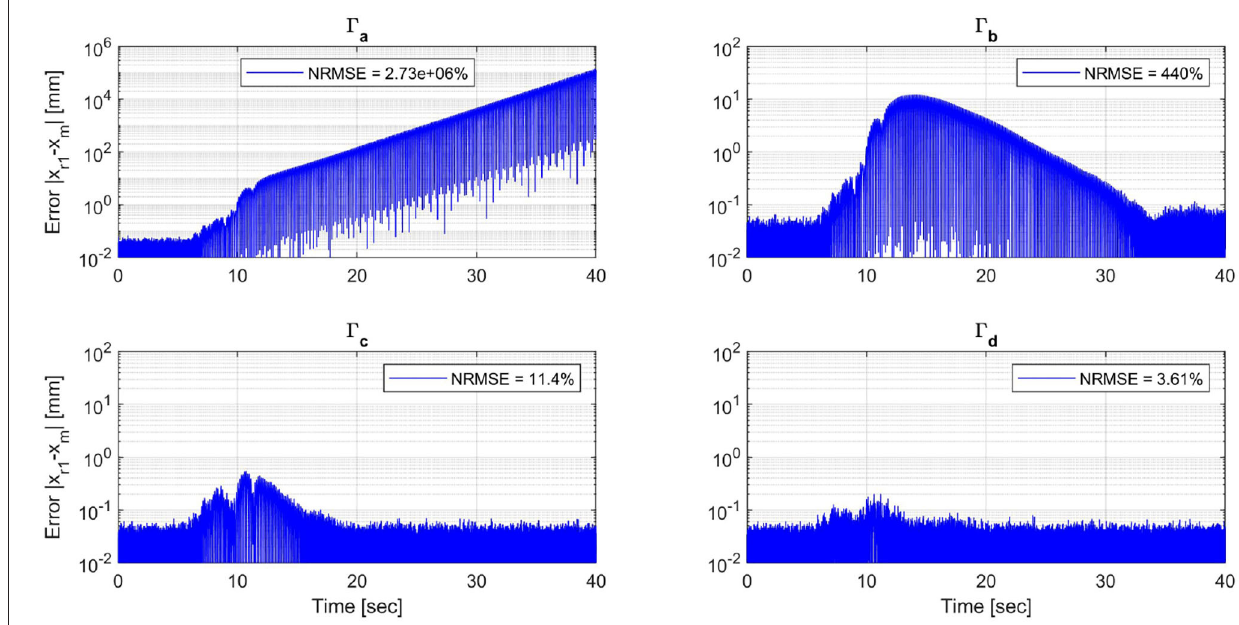
FIGURE 11 | Displacement error for different adaptive gains.